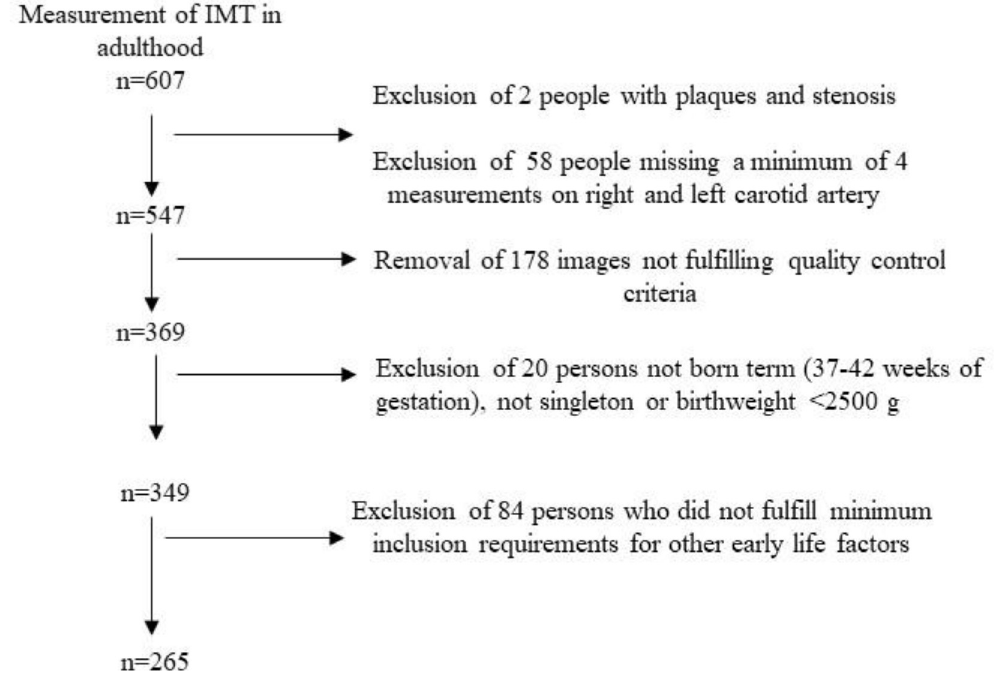
Fig 1. Participant flowchart diagram for IMT and early life